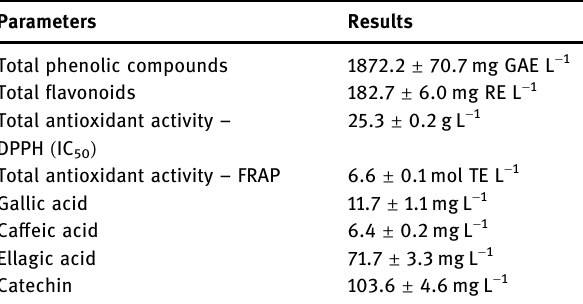
Table 1: Levels of some bioactive components of PJ Parameters